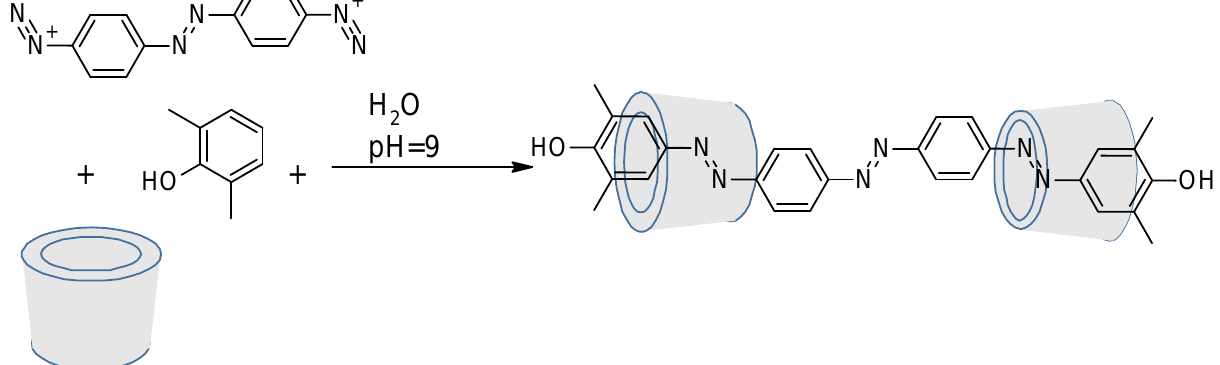
Figure 16. Diazo coupling inside a cyclodextrin for rotaxane synthesis.